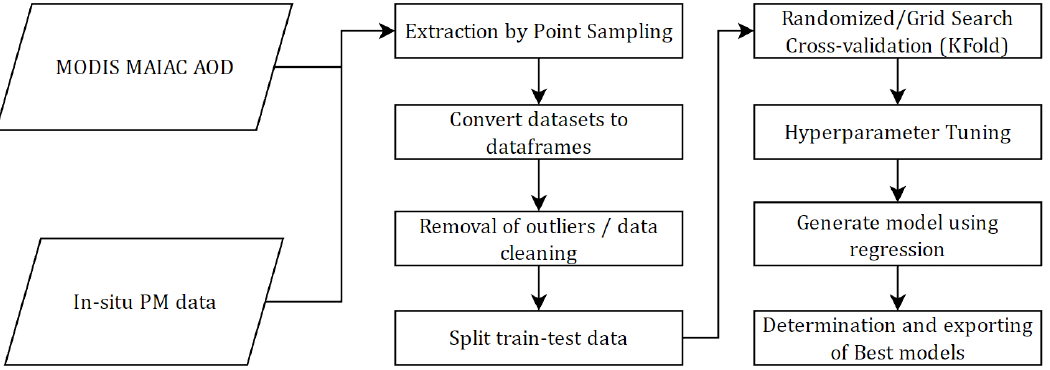
Figure 1. PM modelling workflow using MLR and gradient boosting algorithm.